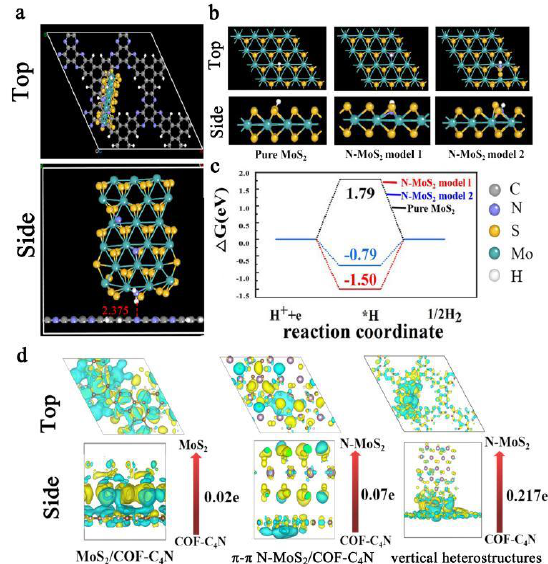
Figure 5. ( a ) Top-view and side-view of the optimized unit cell of N-MoS 2 /COF-C 4 N vertical heterostructures drawing with Device Studio (the hydrogen bond are marked); ( b ) top-view and side- view of optimized *H intermediate of pure MoS 2 (S as active site), N-MoS 2 model 1 (N atom replacing S active site) and N-MoS 2 model 2 (N atom adsorbing on MoS 2 surface and interact with both Mo and S); ( c ) Gibbs free energy of HER profile for different active sites on various models; ( d ) charge density differences for MoS 2 /COF-C 4 N, π - π N-MoS 2 /COF-C 4 N and vertical heterostructures. The yellow and cyan regions represent electron accumulation and depletion, and the isosurface value is 0.0009 e A −3 .